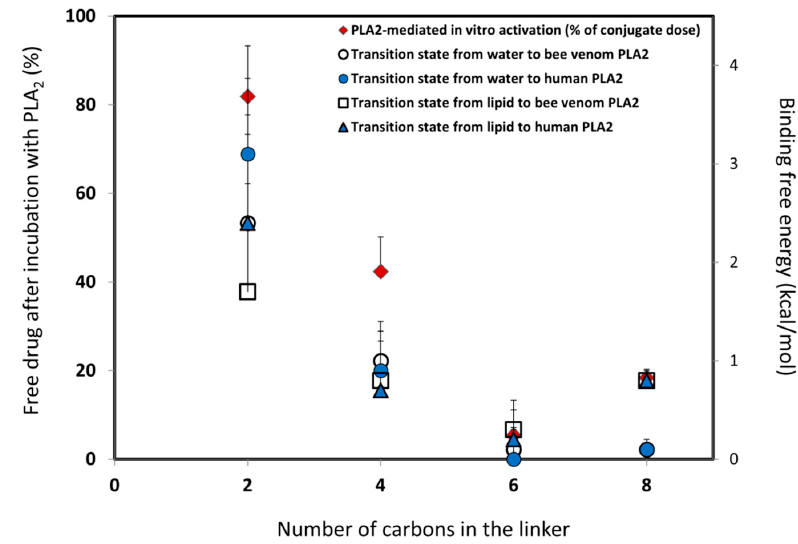
Figure 3. In-silico / in-vitro correlation for PL-diclofenac prodrugs: in-silico prodrug binding free energies in PLA 2 transition state from the initial state of water or lipid (kcal / mol) versus in-vitro results for conjugates with a linker length of two-, four-, six-, and eight-carbon atoms (% of intact complex). Reproduced with permission from the authors of [25].